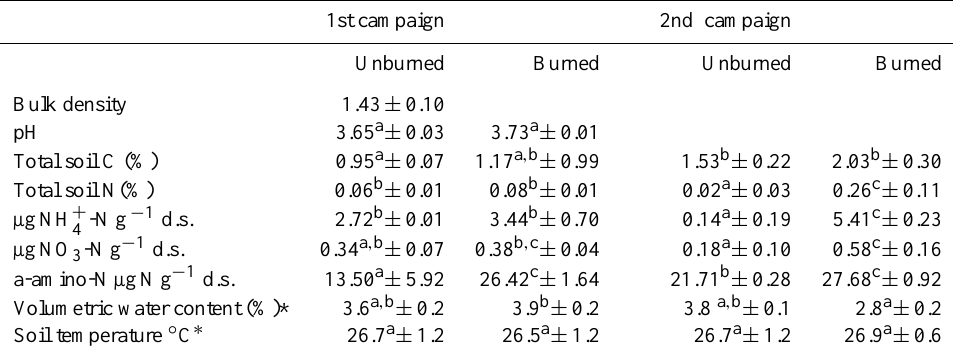
Table 1. A selection of soil chemical characteristics of the unburned and burned plot soils measured during the first (one month after burning) and second field campaign (eight months after burning) for the top 10cm of soil. Different superscript letters indicate significant differences (two-Way ANOVA, P < 0 . 005) among values in the same